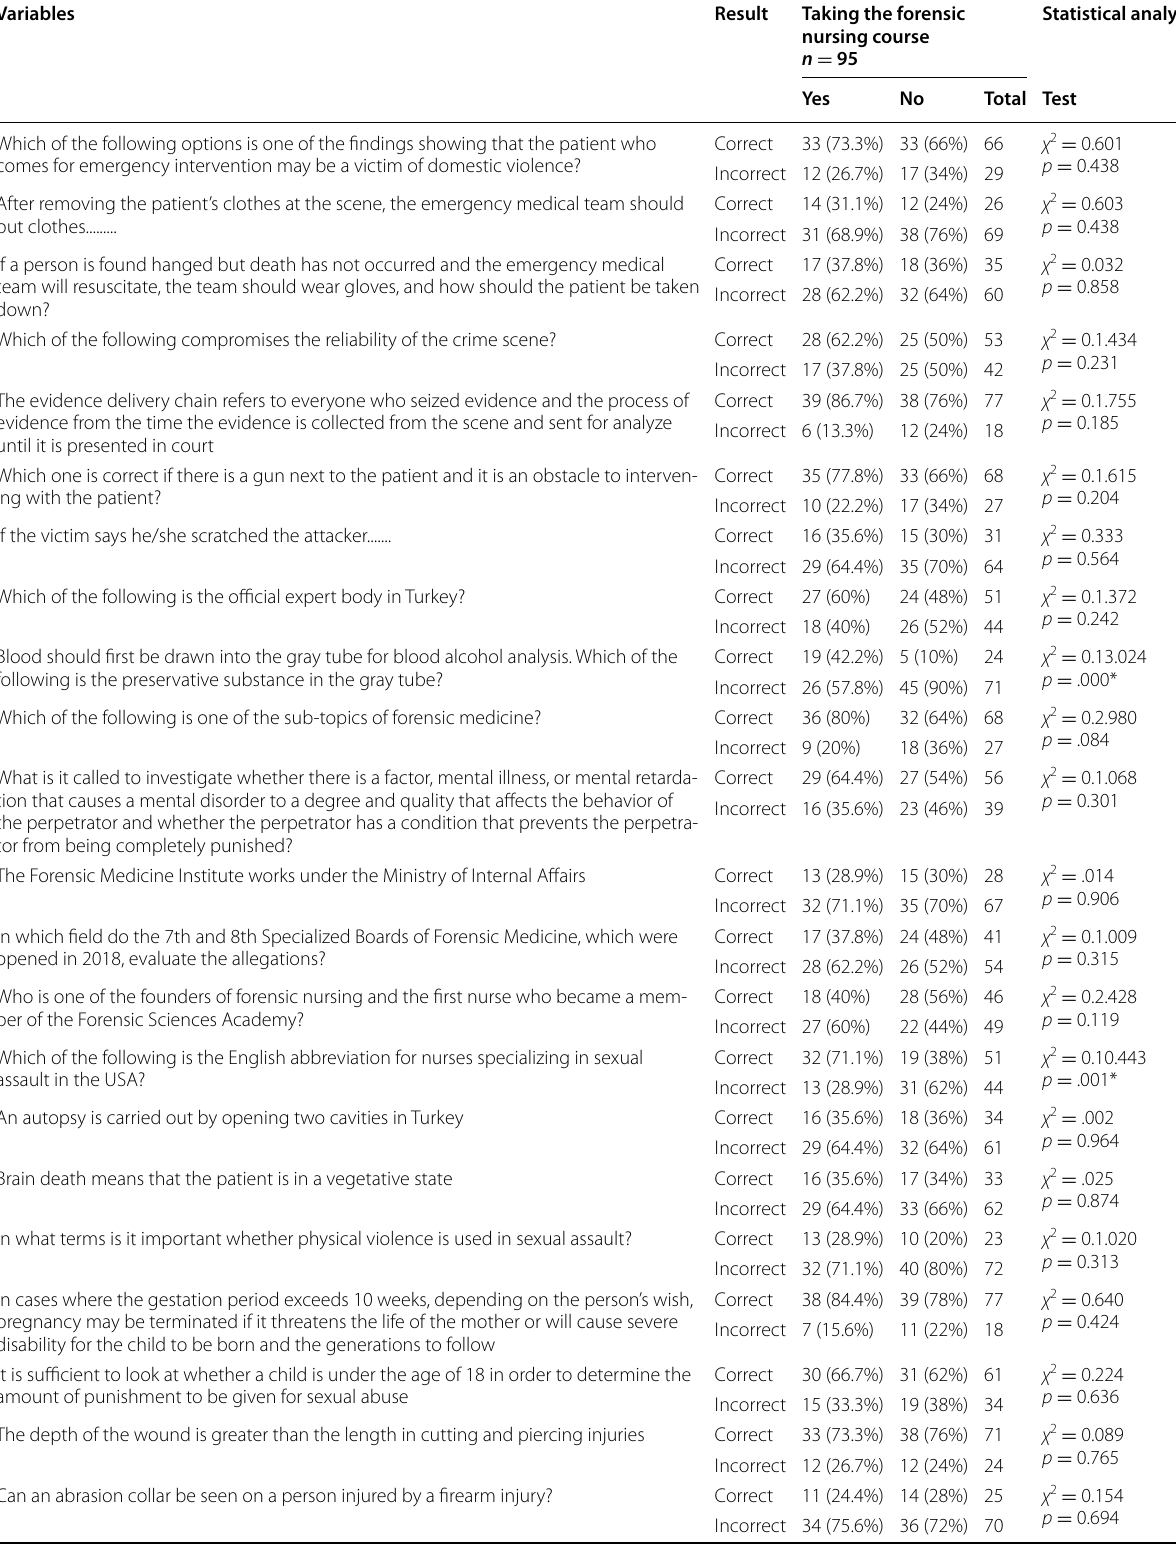
Table 4 Results of the questions on the knowledge level test on forensic nursing and the status of taking the forensic nursing course Variables Result Taking the forensic